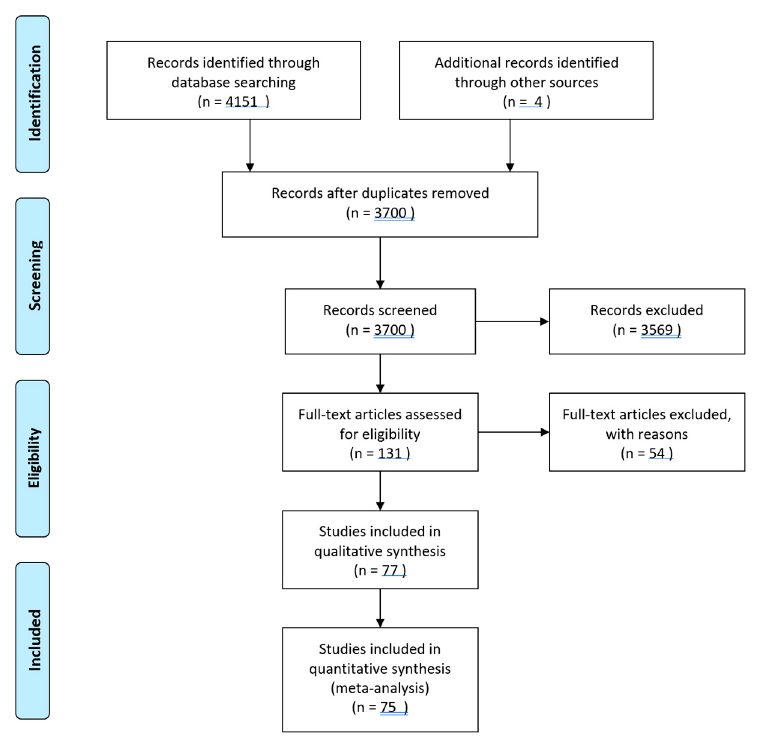
Figure 1. Search flow chart displaying the number of reports screened and then finally included in the review. n = number of